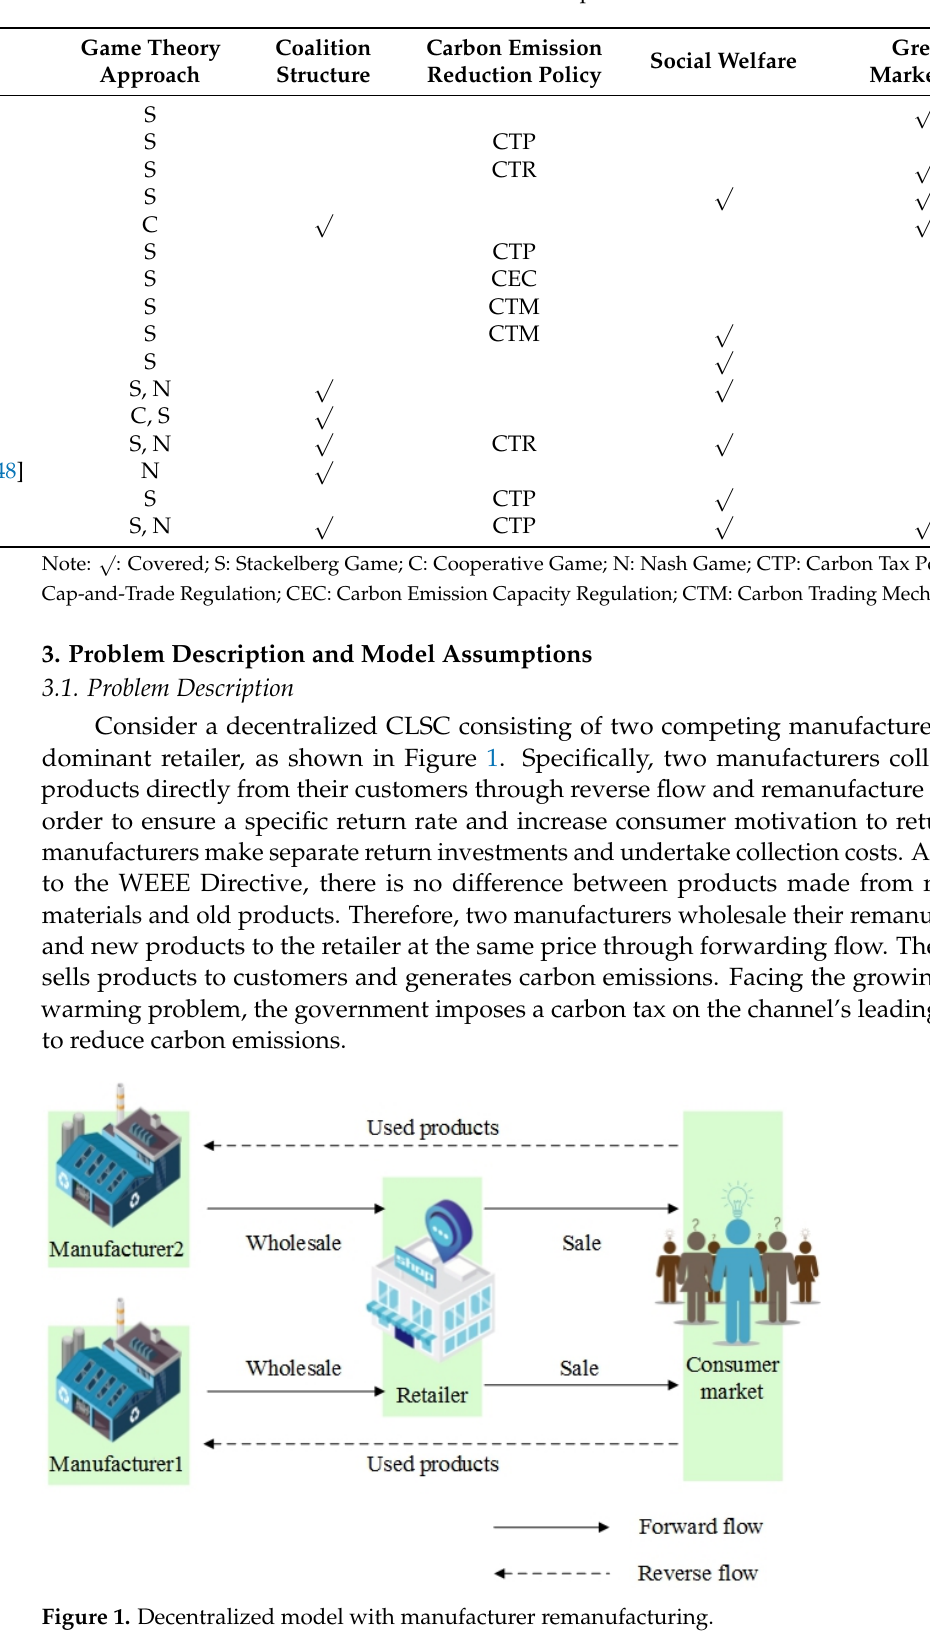
Table 1. The main differences between our works and previous studies.